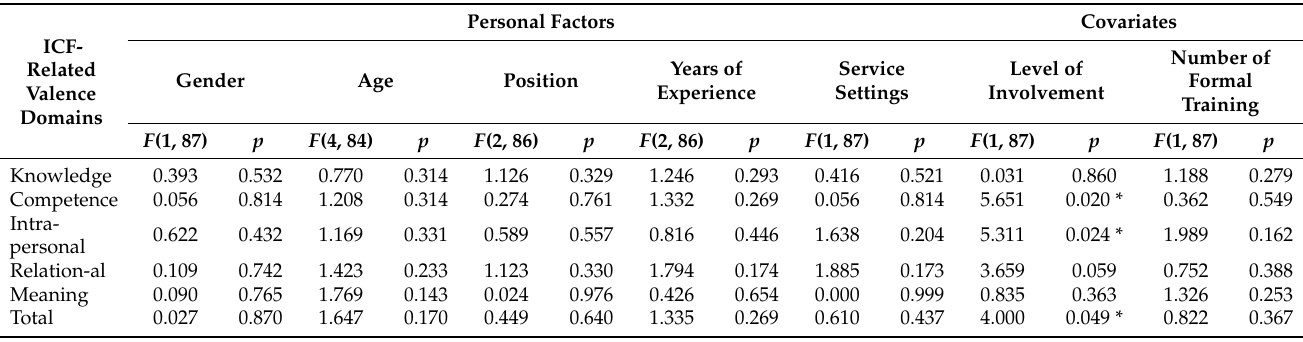
Table 3. One-way Repeated measures ANOVAs results for the interaction effect of personal factors and covariates on scores of ICF-related valence domains.